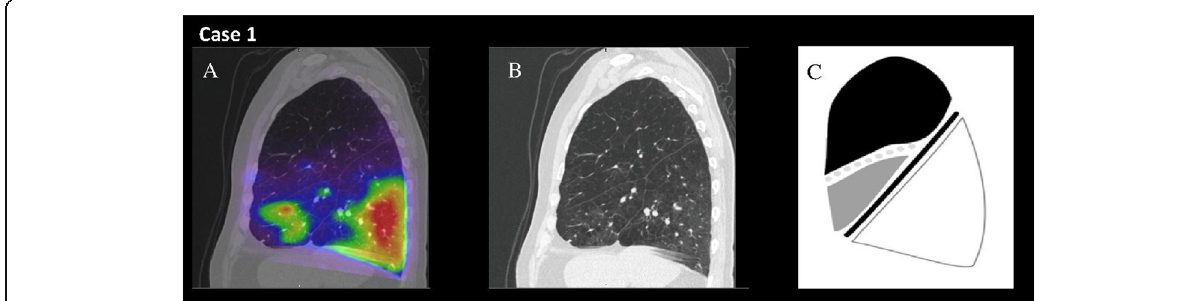
Fig. 2 Highlighted are sagittal fused 68Ga-VQ/PET-CT (panel a ), CT densitometry ( b ), and StratX® report ( c ) images from a participant (case 1) demonstrating an example of concordance of modalities in the upper lobe. Panel A demonstrates perfusion scanning with significantly reduced perfusion to RUL and RML (RUL 11%, RML 6%, RLL 43%). Panel B demonstrates CT appearance, with C illustrating destruction severity, with 79% of RUL, 63% of RML, and 48% of RLL voxels with measured density < − 910